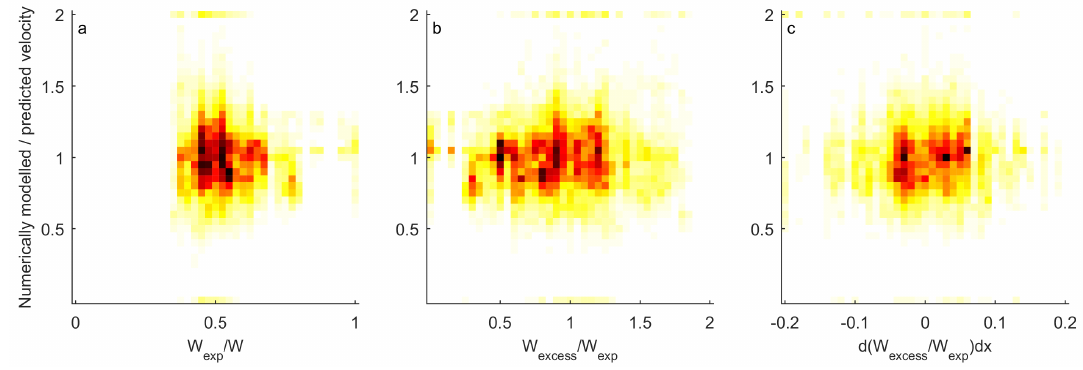
Figure A2. Measured velocity from the model divided by predicted velocity from the tool against three expressions of excess width. Lack of trend between velocity deviation and width measures indicates that velocity predictions will not improve from including width in the regression. ( a ) ideal width divided by local width, ( b ) excess width divided by ideal width and ( c ) along-channel derivative of excess width divided by ideal width. Colours in the plot become more yellow with increasing point density.